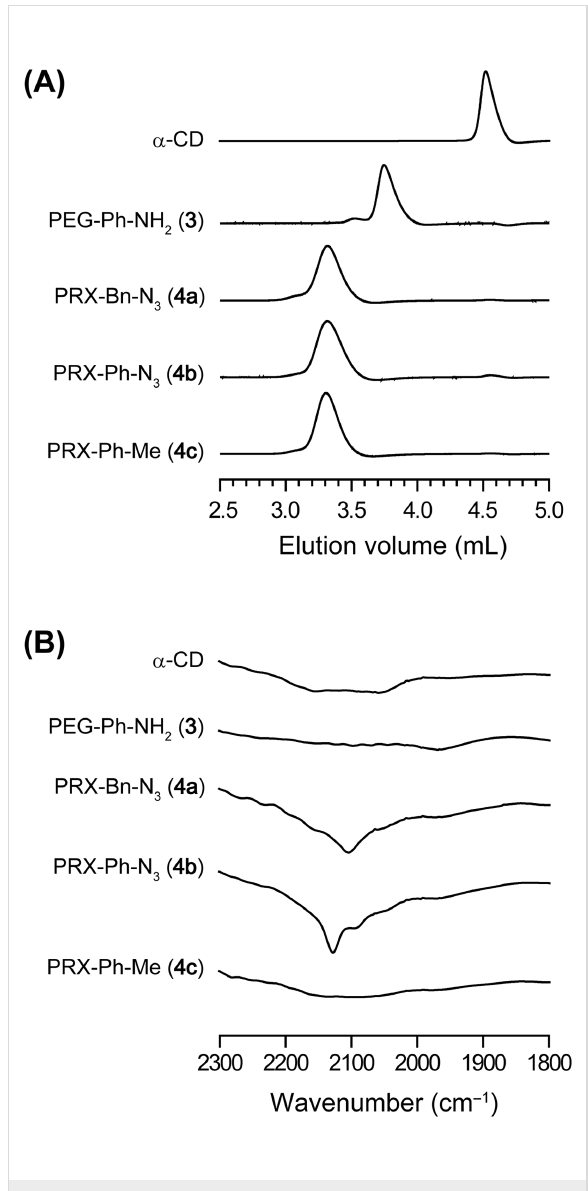
Figure 2: (A) SEC charts of α -CD, PEG-Ph-NH 2 ( 3 ), PRX-Bn-N 3 ( 4a ), PRX-Ph-N 3 ( 4b ), and PRX-Ph-Me ( 4c ). (B) FTIR transmission spectra of α -CD, PEG-Ph-NH 2 ( 3 ), PRX-Bn-N 3 ( 4a ), PRX-Ph-N 3 ( 4b ), and PRX-Ph-Me ( 4c